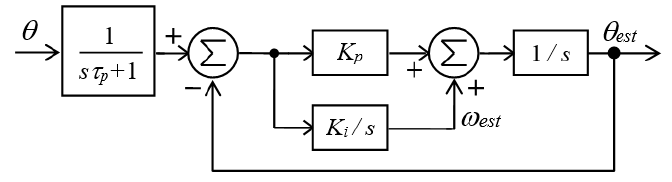
Figure 5. The small-signal model of FFPLL1.